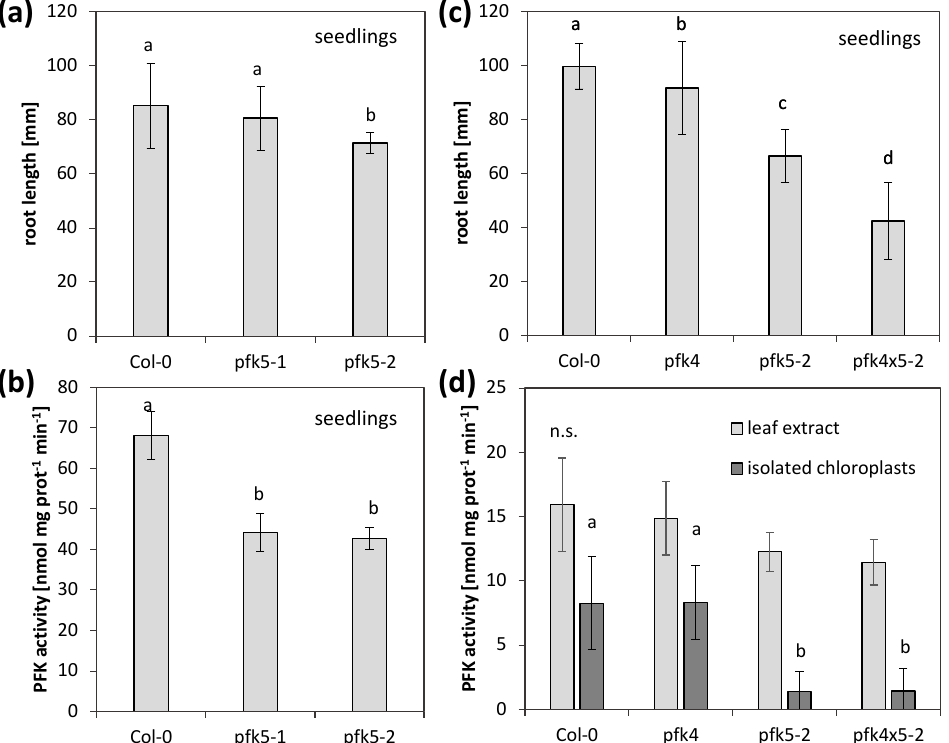
Figure 8. Analysis of two independent PFK5 T-DNA insertion mutants. ( a ) A. thaliana seedlings of pfk5-1 (Salk_067384) and pfk5-2 (Sail_694_A07) were grown under long-day conditions on solid 1/10 Hoagland medium together with the wildtype Col-0. After 14 days, root length was determined. Data represent means ± SD of 30 plants. Letters indicate significant differences at p < 0.05 (ANOVA, Post hoc Tukey test). ( b ) PFK activity of 14-day-old seedlings of Col-0, pfk5-1 and pfk5-2 grown on 1/10 Hoagland medium. Different letters indicate significant differences in protein activity at p < 0.05 (ANOVA, Post hoc Tukey test, n = 3–4). ( c ) Root length of 14-day-old seedlings, grown under long-day conditions on solid 1/10 Hoagland medium. Col-0 wildtype was compared to pfk5-2 (Sail_694_A07), pfk4-1 (SALK_012602) and the double mutant pfk5-2 pfk4-1 . Data represent means ± SD of 3 independent experiments with 20 individuals each. Letters indicate significant differences at p < 0.05 (ANOVA, Post hoc Tukey test). ( d ) PFK activity in crude leaf extracts and isolated chloroplasts from 5-week-old rosette leaves of pfk4-1 , pfk5-2 and the double mutant in comparison to wildtype Col-0. Data are means ± SD. Letters indicate significant differences among genotypes at p < 0.05 (ANOVA, Post hoc Tukey test, n = 4–6). n.s., not significant.